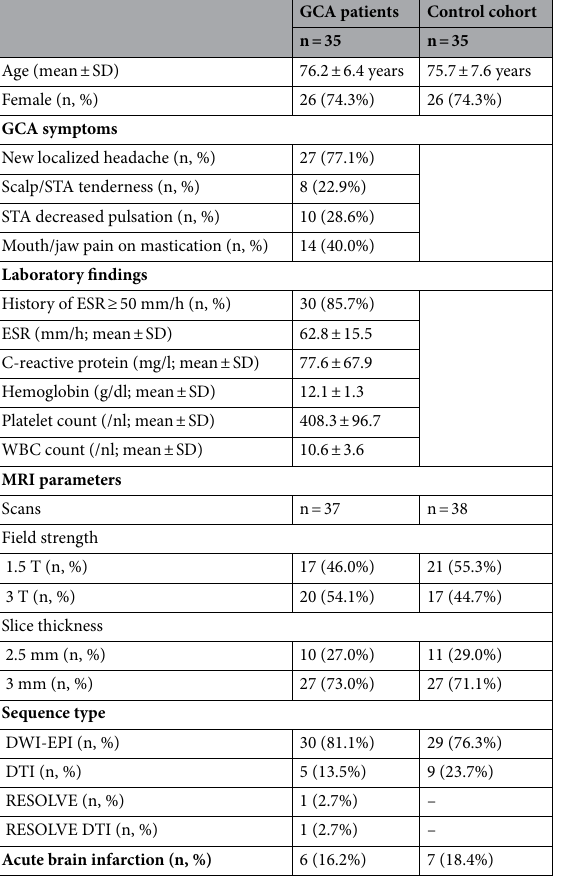
Table 1. Clinical and laboratory characteristics of GCA patients and radiological features of DWI-MRI. DWI diffusion-weighted imaging, DTI diffusion tensor imaging, ESR erythrocyte sedimentation rate, GCA giant